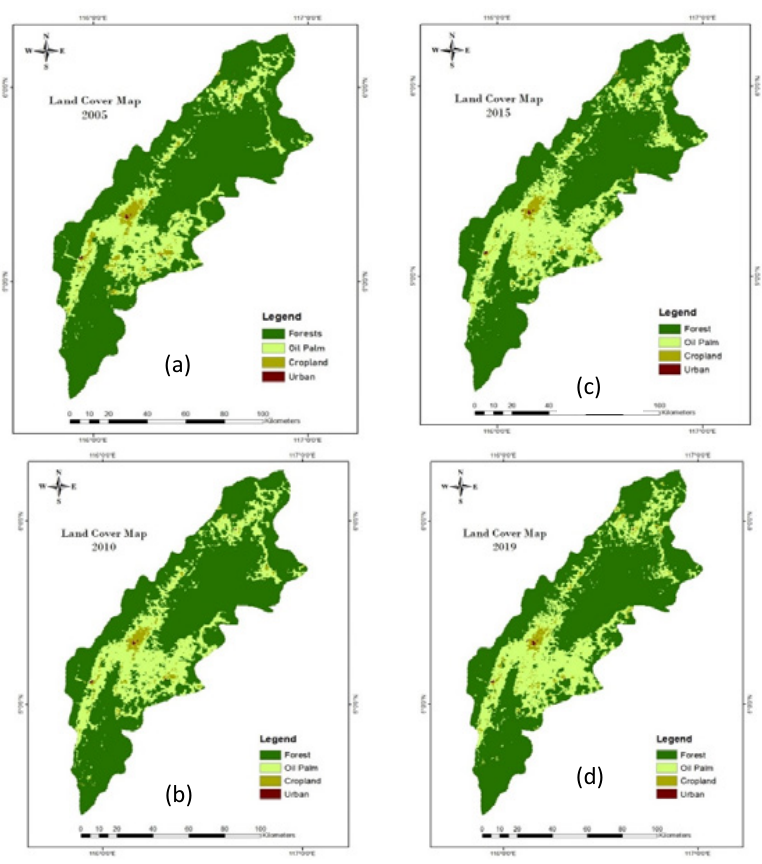
Fig. 4: Land cover map of each district for the year (a) 2005; (b) 2010; (c) 2015; and (d) 2019